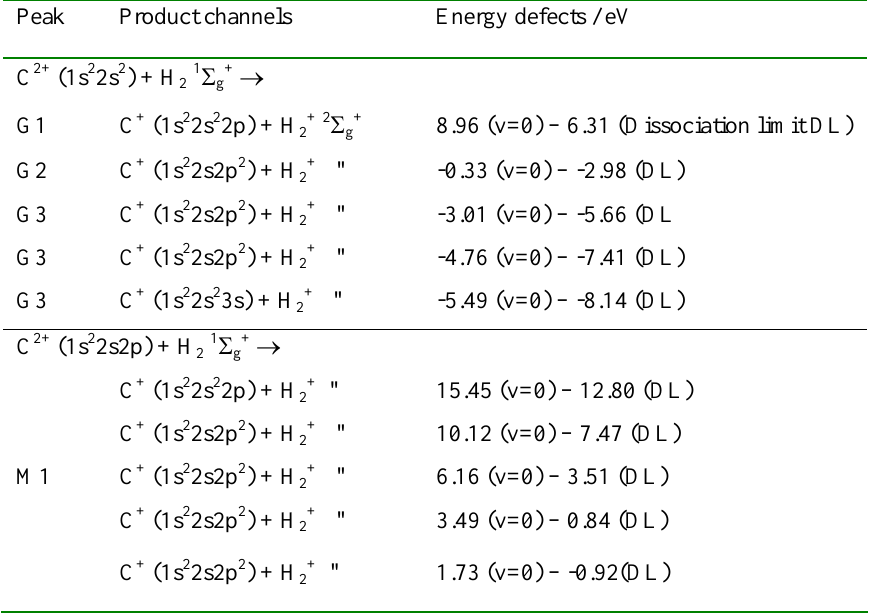
Table 2: Main reaction channels for one electron capture by C 2+ ions in H Peak Product channels Energy defects /